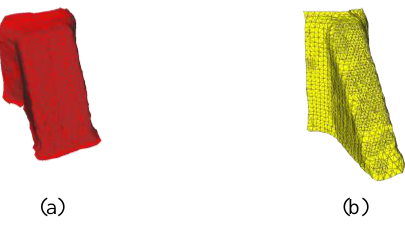
Figure 13. Final decomposition result